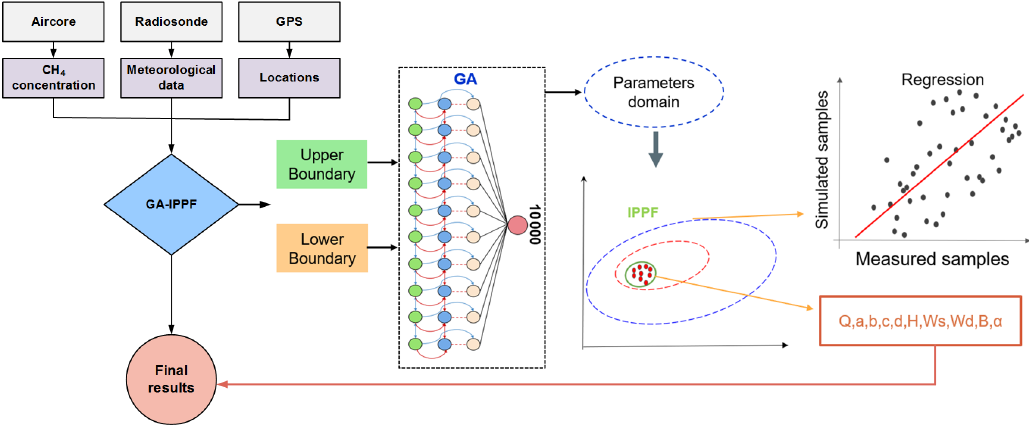
Figure 2. Flow chart of the GA-IPPF model, including data inputs and processes in each step.